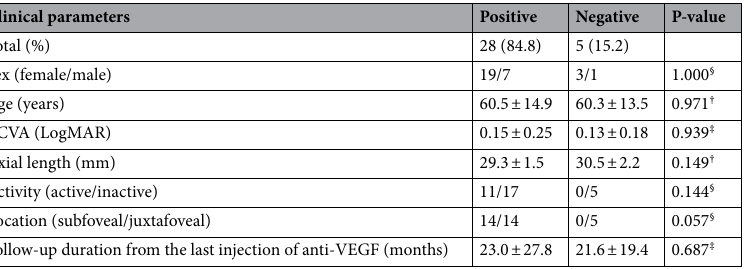
Table 1. Comparison of characteristics between myopic choroidal neovascularization eyes with or without blood flow signals. OCTA optical coherence tomographic angiography, BCVA best-corrected visual acuity, VEGF vascular endothelial growth factor, LogMAR logarithm of the minimum angle of resolution. † Student’s t -test; ‡ Wilcoxon rank sum test; § Fisher’s exact